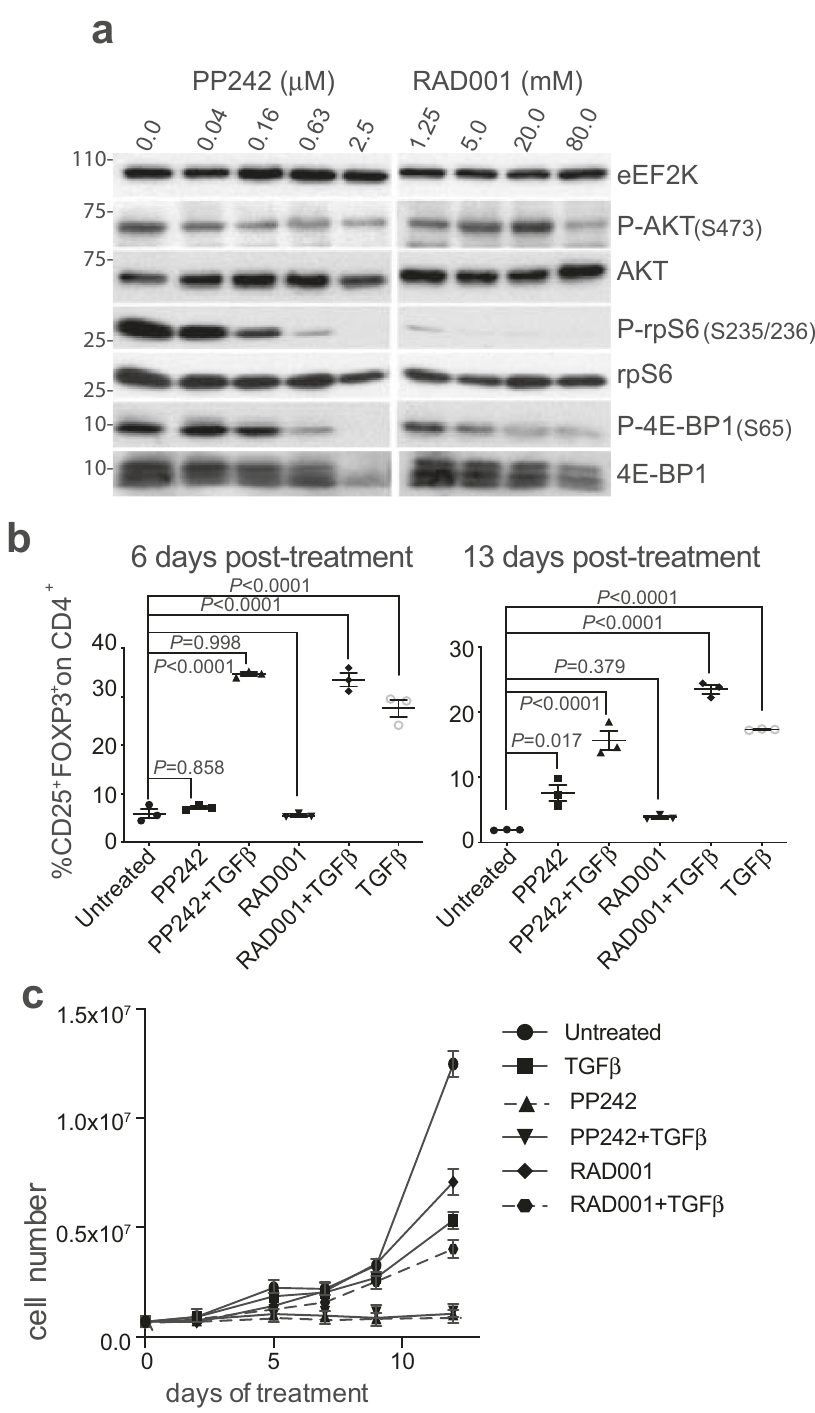
Fig. 1 mTOR inhibition impairs human T cell differentiation. a Titration of mTORC1 inhibitor RAD001 and dual mTORC1/2 inhibitor PP242 in human CD4 + T cells. Human naive CD4 + T cells were isolated from PBMCs of healthy donors as shown in Supplementary Fig. 1a. Isolated CD4 + T cells were treated with plate-bound α CD3 antibody, soluble α CD28, and 150 U/ml IL-2, treated with increasing doses of the indicated drugs or DMSO, for 4 d and equal amounts of whole-cell lysates analyzed by immunoblot. A representative immunoblot from one donor is shown. Four independent donors were evaluated. b RAD001 mTORC1 inhibition + TGF-beta treatment (TGF β in fi gures) increases CD4 + FOXP3 + T cells. Isolated CD4 + T cells were activated and expanded for 13 d in the presence of DMSO, 1 μ M PP242, 20 nM RAD001, 2 ng/ml TGF-beta or TGF-beta plus mTOR inhibitors with 150 U/ml IL-2 as needed. At 6 and 13 d post activation, cells were stained for CD4, CD25, FOXP3, and viability analyzed by fl ow cytometry. P values were determined by statistical analysis using one-way ANOVA tests with Dunnett post-ANOVA test determination. Values shown are mean with standard error of the mean (SEM) of three independent studies. c mTORC2 is required for T-cell proliferation. CD4 + T cells were activated, treated, and expanded as described in b . Shown is a time course of total cell number (cell concentration × culture volume). Data represent three independent studies with SEM shown. Source data are provided as a Source Data fi